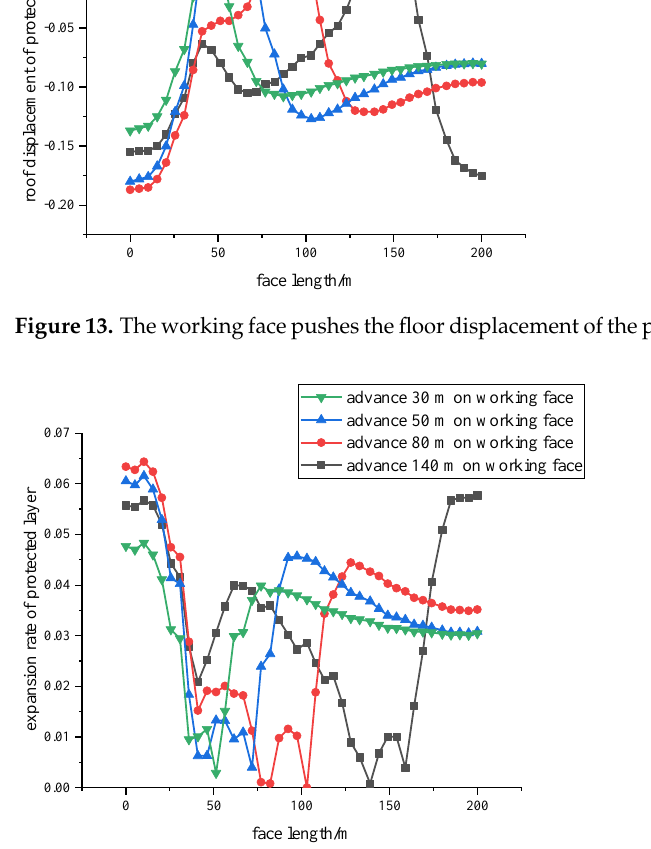
Figure 14. Expansion rate diagram of working face advancing at different distances.